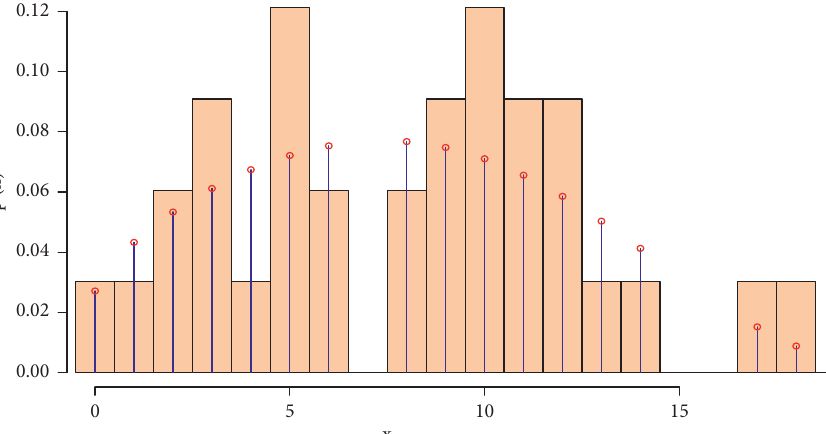
Figure 16: Graphical plots of the data and the PMF of the DEOWE distributions, as we can see in the plot which is the PMF of the distributions with the random variable with value x , where x is the number of deaths per day and P(x) is the probability for x